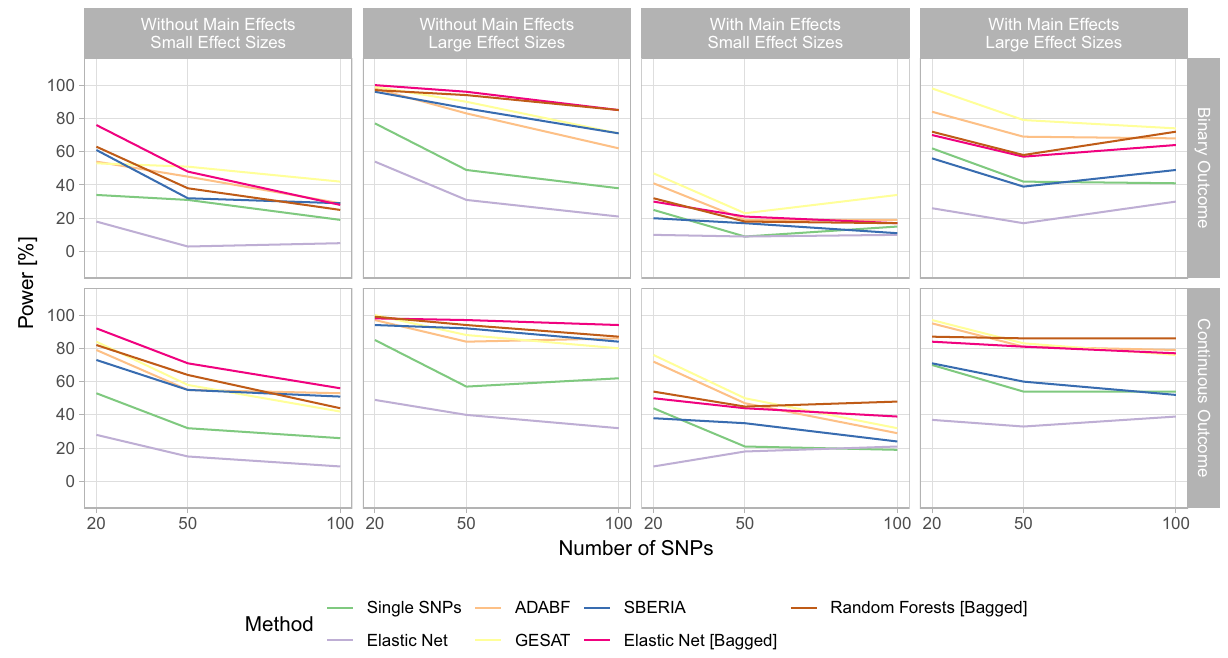
Figure 5. Statistical power of the single SNP test, the GRS-based test using elastic net, ADABF, GESAT, SBERIA, the bagged GRS-based test using elastic net, and the random-forests-based test for testing GxE interactions in the second scenario (see Eq. (5)) of the simulation